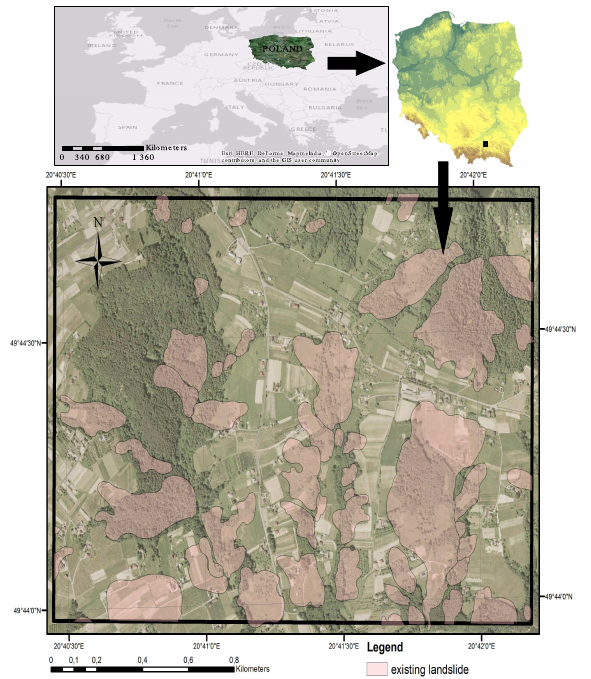
Figure 2: Location of the study area with the existing landslides and ortoimage